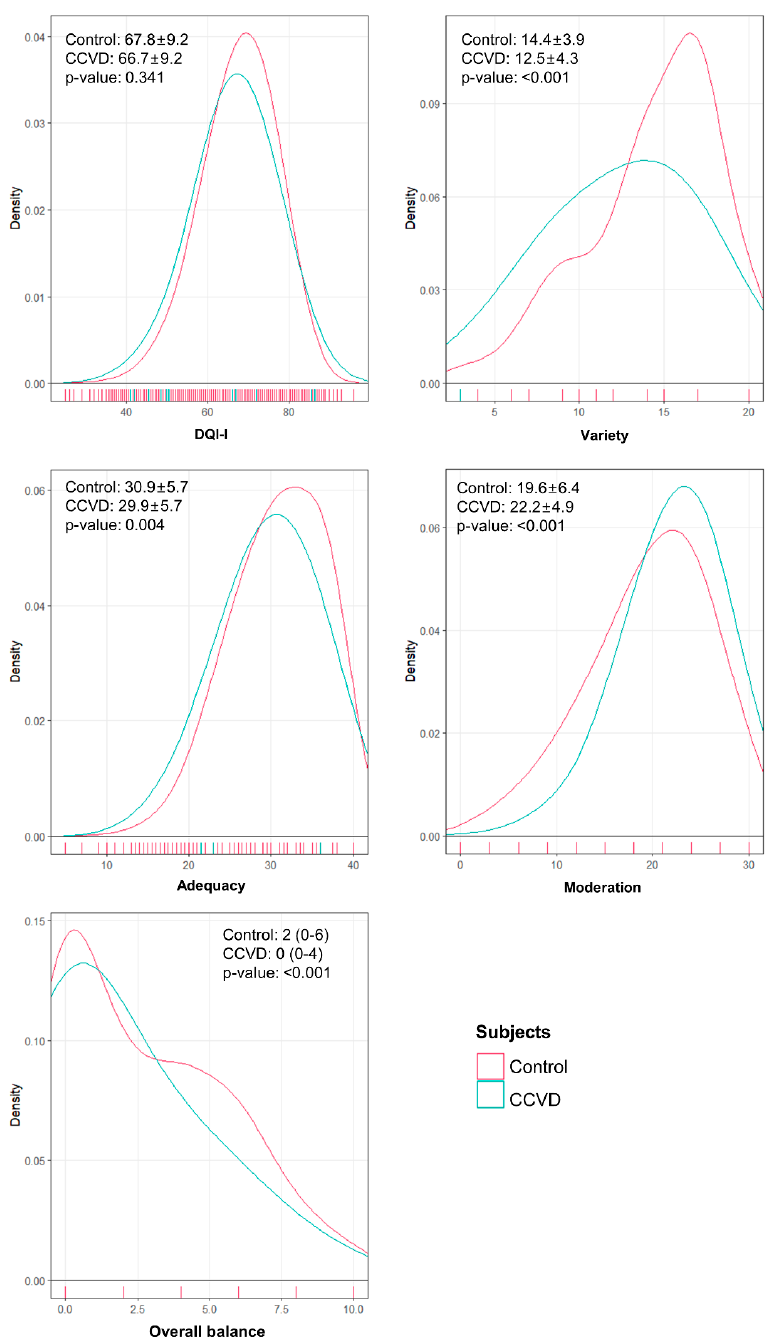
Figure 1. DQI-I component score densities. DQI-I, Diet Quality Index—International; CCVD, cerebrovascular and cardiovascular diseases. Total DQI-I, variety, adequacy, and moderation scores are presented as means and standard deviations. Overall balance scores are presented as medians with interquartile ranges. p -values were obtained by survey-weighted linear regressions.